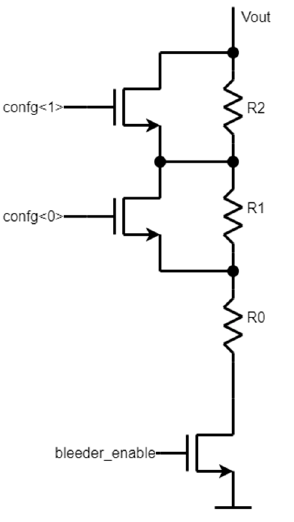
Figure 7. Current bleeder